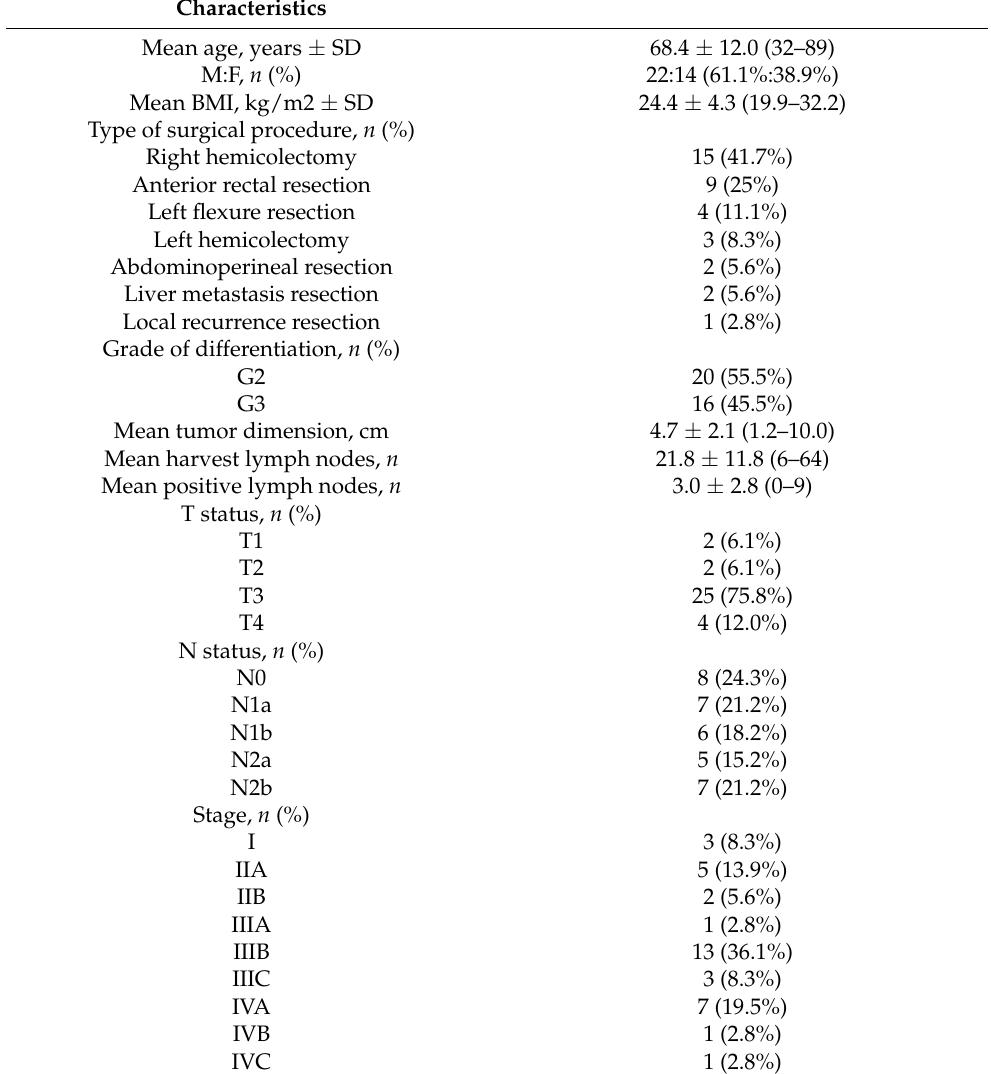
Table 2. Characteristics of patients with colorectal cancer ( n =